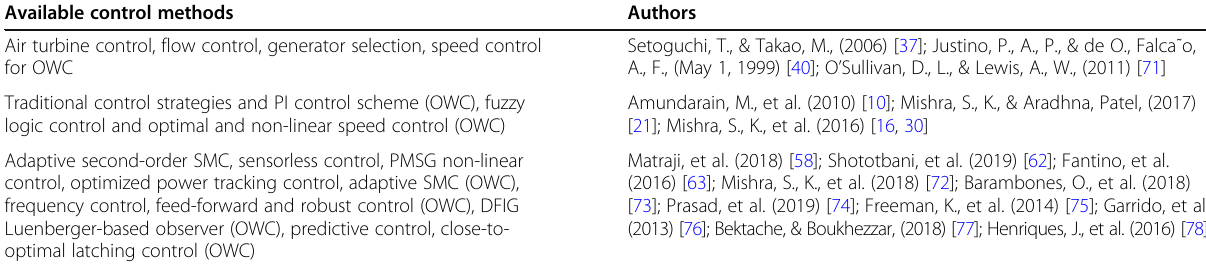
Table 2 Various control methods for renewable energy systems Available control